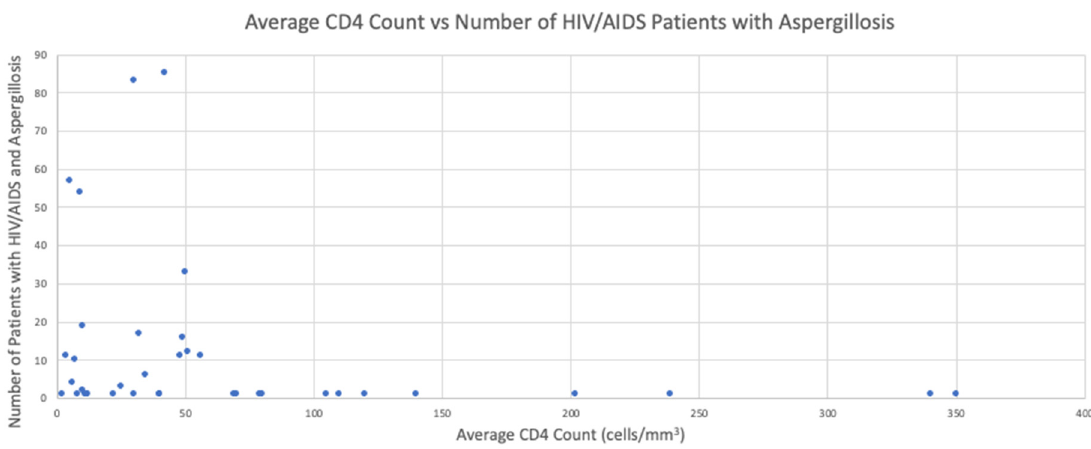
Figure 3. The average CD4 count vs. number of HIV/AIDS patients diagnosed with aspergillosis. Results taken from the 54 publications reviewed.